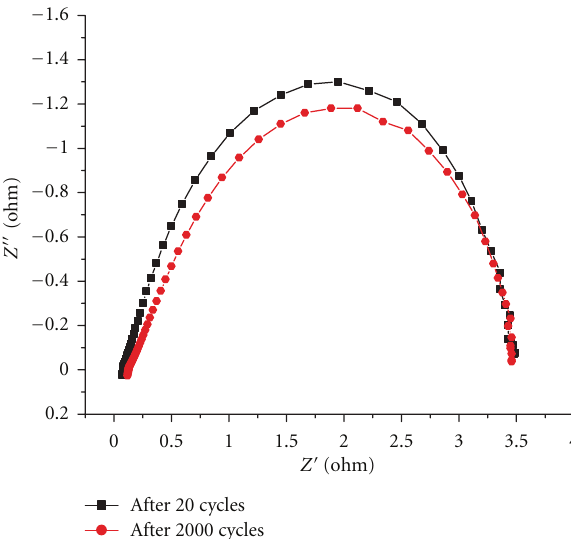
Figure 7: Comparison of impedance curves during